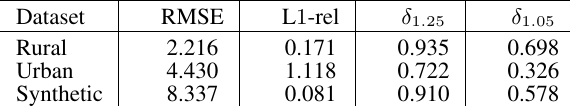
Table 1. Quantitative results achieved by our approach. The val- ues represent the mean score, averaged over all images in the cor- responding dataset. The last two columns represent the accuracy at a threshold of 25 % and 5 % w.r.t. to the ground truth. As shown in Table 1, our results vary greatly between the differ- ent datasets. The best accuracy is achieved on the rural dataset, followed by the synthetic dataset. The results achieved on the urban dataset are considerably worse, which we assume to be caused by the bad picture quality and the faulty ground truth. Figure 4 shows examples of the predicted depth maps from each dataset, together with the corresponding reference image and the ground truth. In this, the depth is color coded, going from yellow (near) via red to blue (far). In the case of the two real- world datasets (rural and urban), the examples clearly show the errors in ground truth that have been induced by